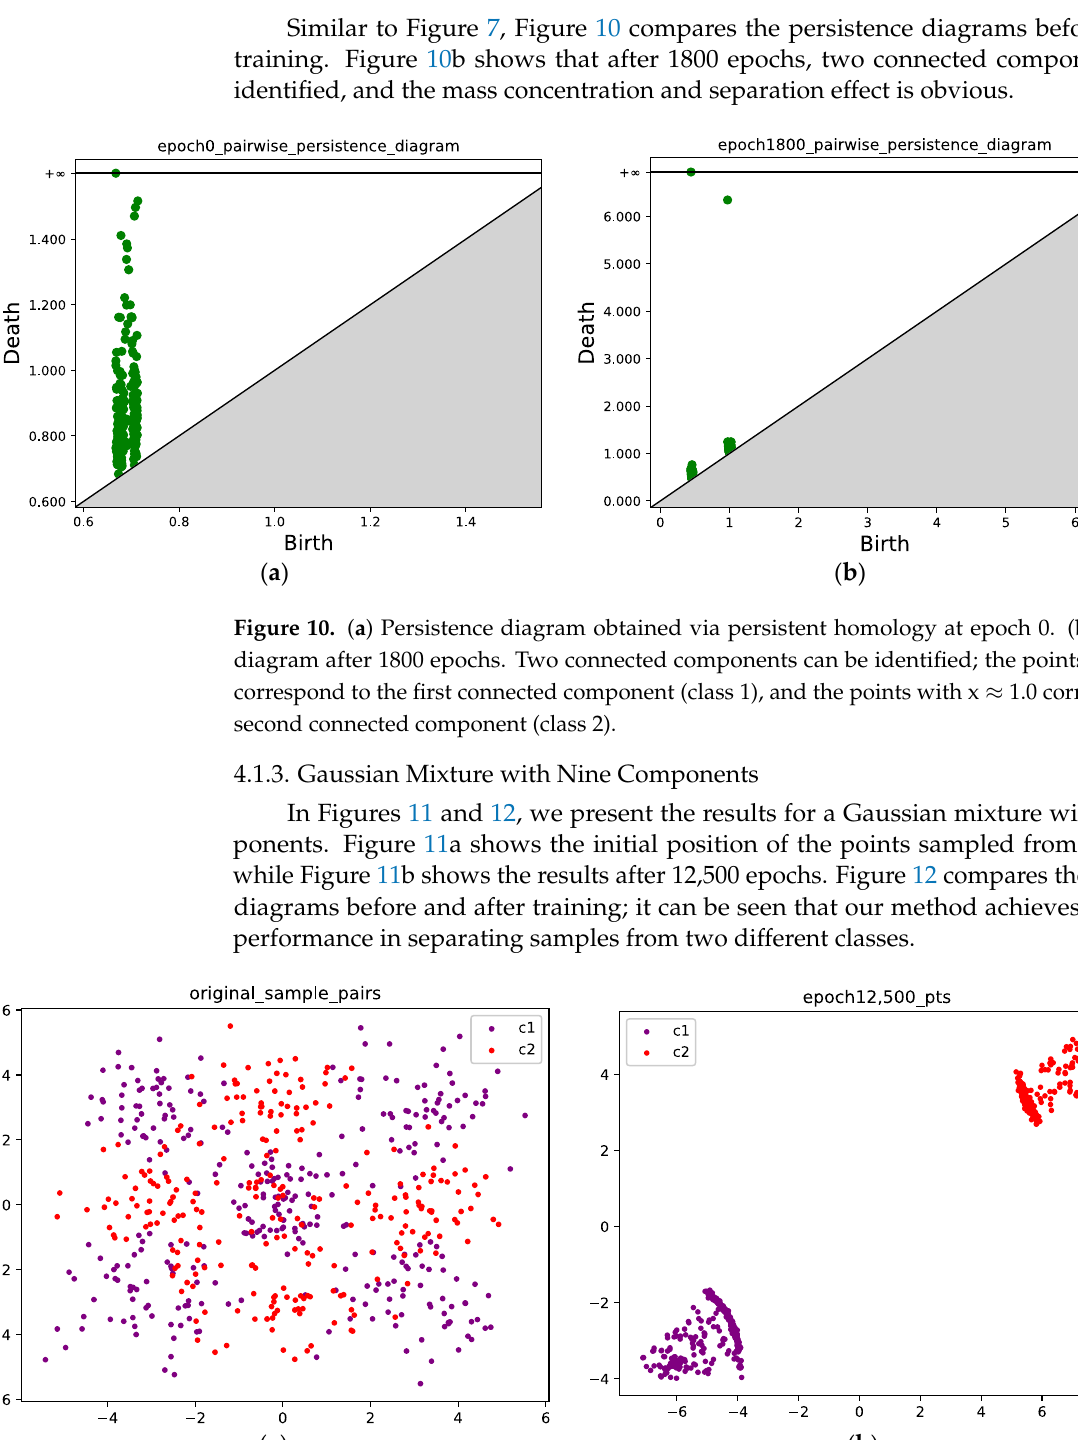
Figure 9. ( a ) Weight function values and contour lines evaluated on the mesh at epoch 0; the points from class 2 correspond to larger values. ( b ) Weight function values and contour lines evaluated on the mesh after 1800 epochs.